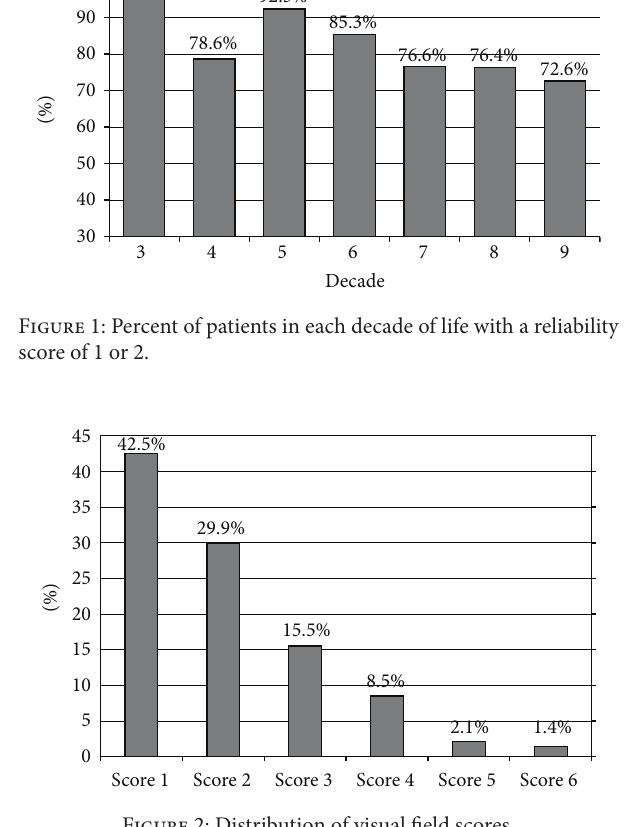
F 2: Distribution of visual �eld scores.